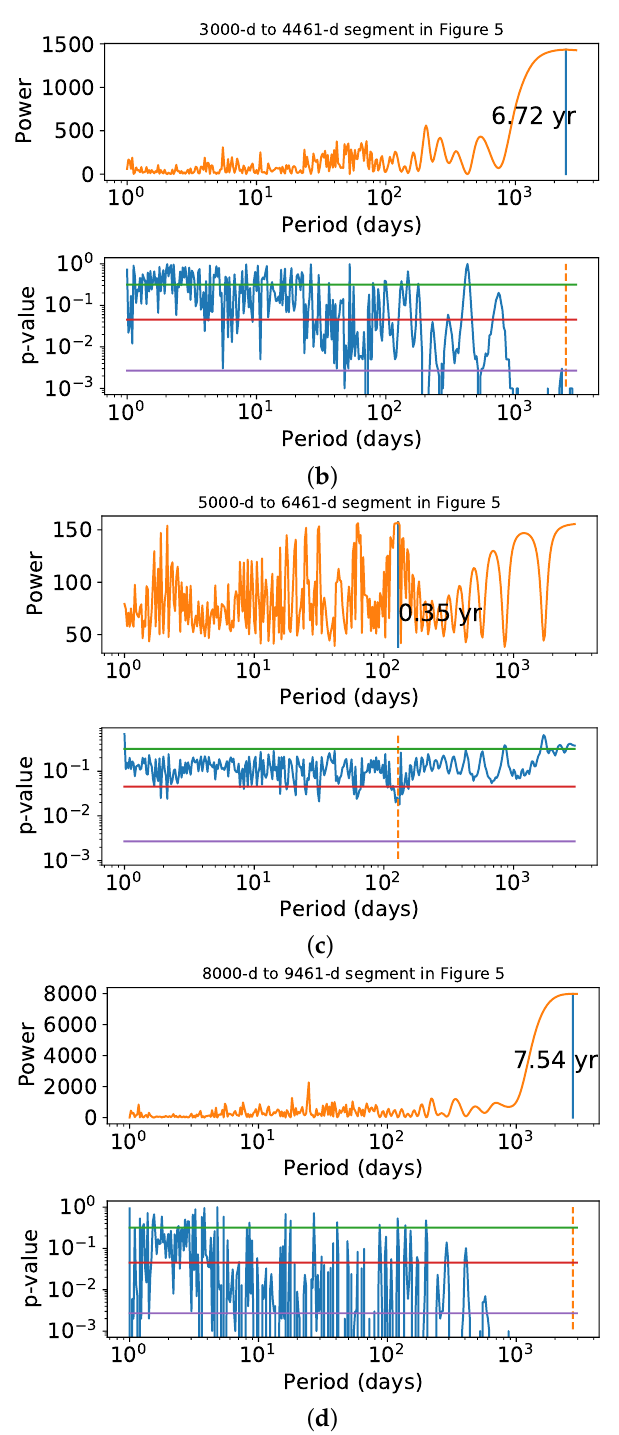
Figure 11. Panel ( a ) is the same in Figure 5. Panel ( b – d ) are power and p -value diagrams for several 4 years segments selected from Panel ( a ). Similar plots for the total TSI data are shown in Panel ( d ) of Figure 5. The green, red, and purple horizontal lines in Panel ( b – d ) show the 1-sigma, 2-sigma, and 3-sigma uncertainty, respectively. The strongest cycles are marked by vertical